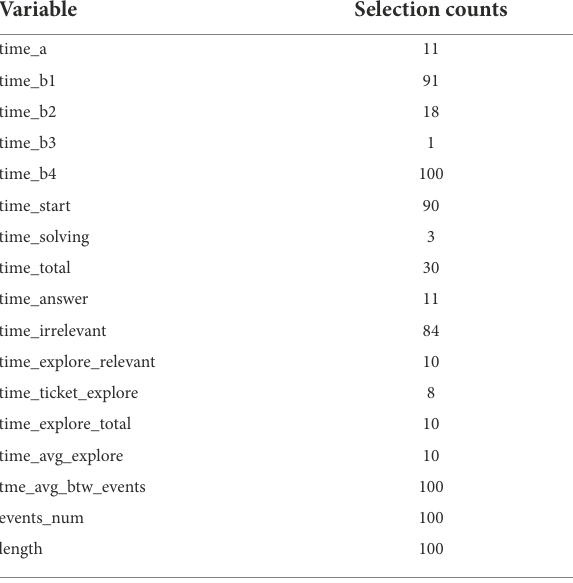
TABLE 5 Variables selection counts out of 100-times repeats for students with incorrect answers. Variable